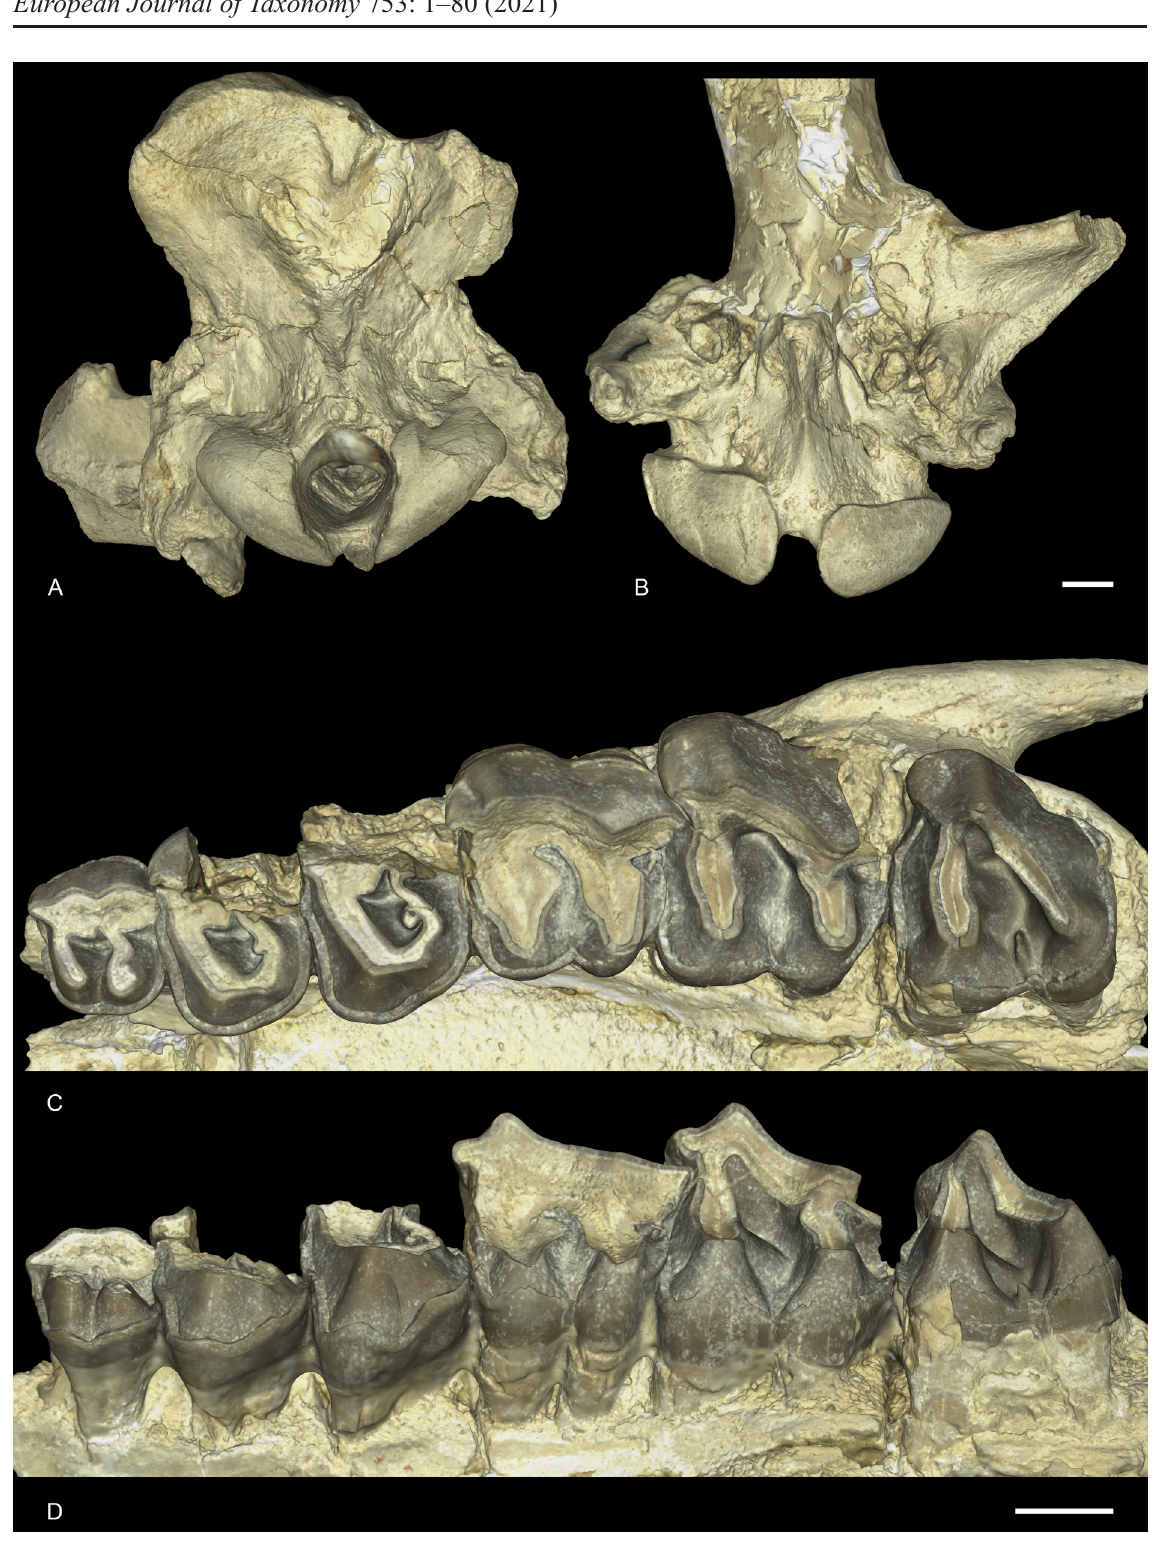
Fig. 10. Ronzotherium elongatum Heissig, 1969 from Pernes (early Oligocene?). – A–B . Skull FSL-9601. A . Posterior view. B . Close-up view of the posterior part in ventral view. – C–D . Left P2–M3 of the skull FSL-9601. C . Occlusal view. D . Lingual view. Scale bars: 2